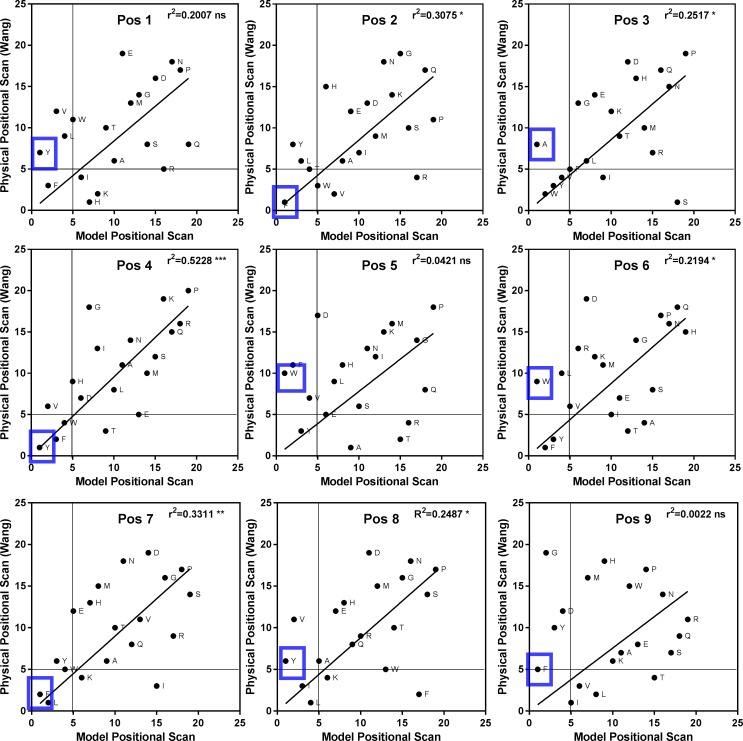
Comparison of amino acid ranking from physical and model positional scanning libraries.Binding affinities for the (19 x 9 = 171) mixtures obtained from the screening of the physical protein or modeled protein encoded by HLA-DP2 (HsDPA1*0103, HsDPB1*0201) were ranked from 1–19, where 1 represents the lowest value and therefore highest binding affinity. Correlations were performed on scatterplots, Coefficients of determination (r2) derived from Pearson coefficients (r) are recorded in upper right corner.